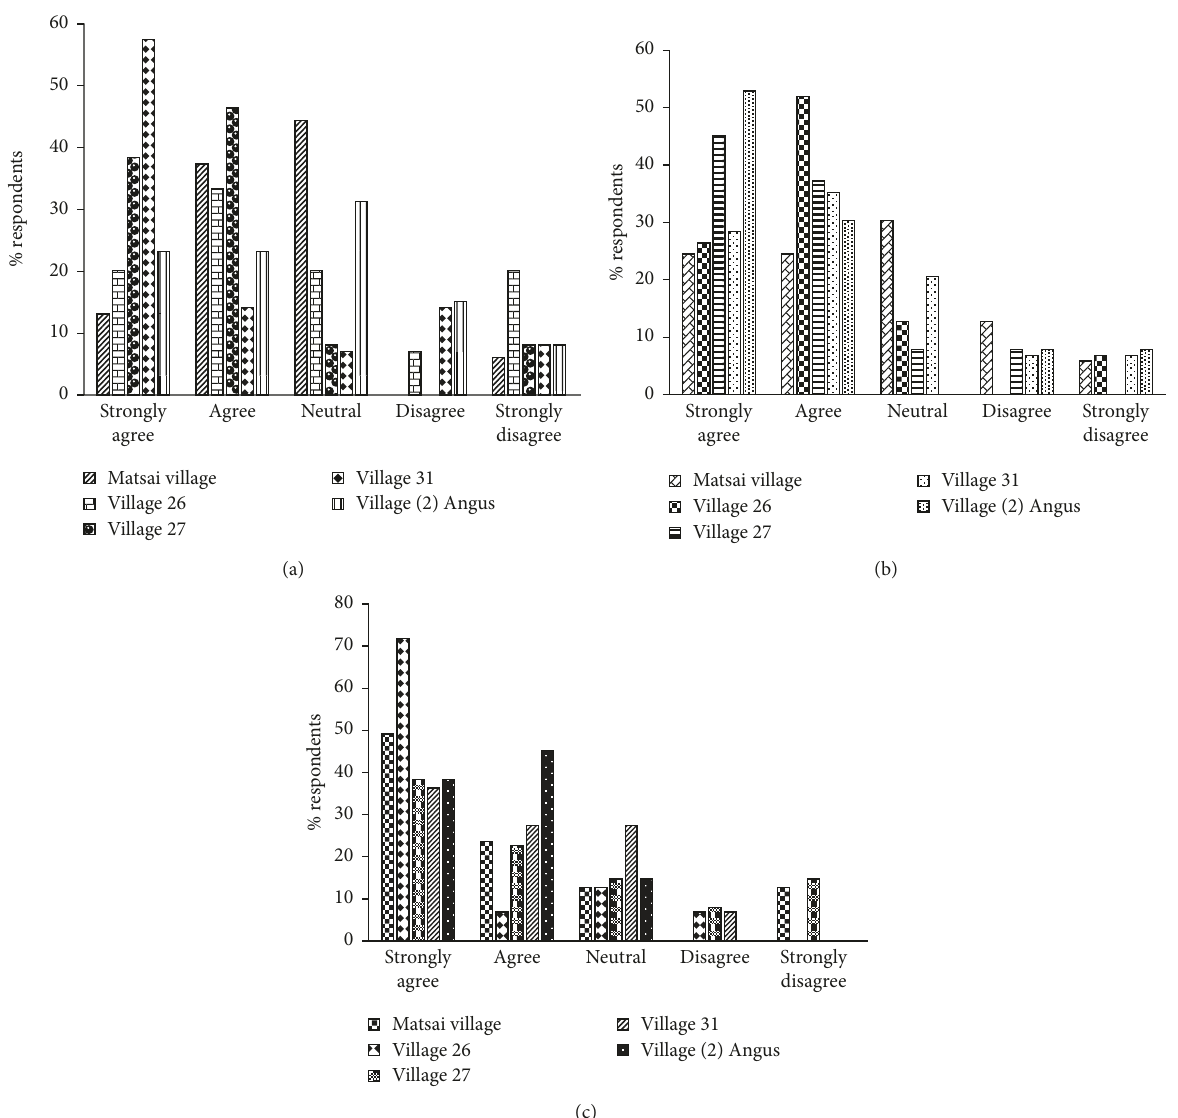
Figure 5: Bar graphs (a)–(c) show percentages of respondents and their attitude ratings towards SVC using the Likert-type scale. Rating scale is as follows:1 strongly agree, 2 agree, 3 neutral, 4 disagree, and 5 strongly disagree. (a) SVC is more of a liability. (b) SVC is for (cid:31) (cid:31) (cid:31) (cid:31) (cid:31) foreign interests. (c) The relationship between SVC and local communities is